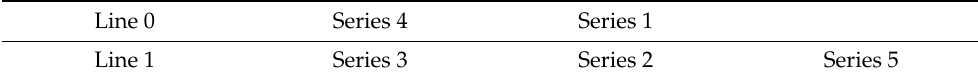
Table 4. Example of production